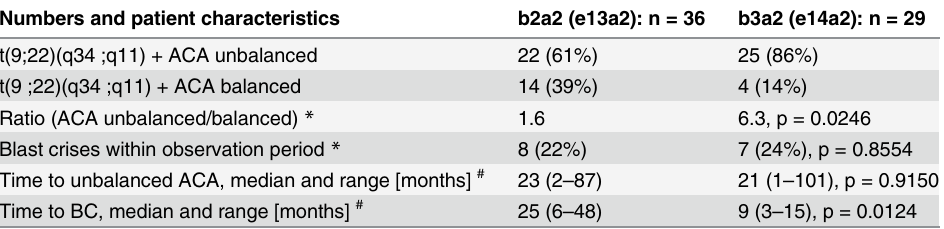
Table 2. Classification of ACA arisen during long term treatment with